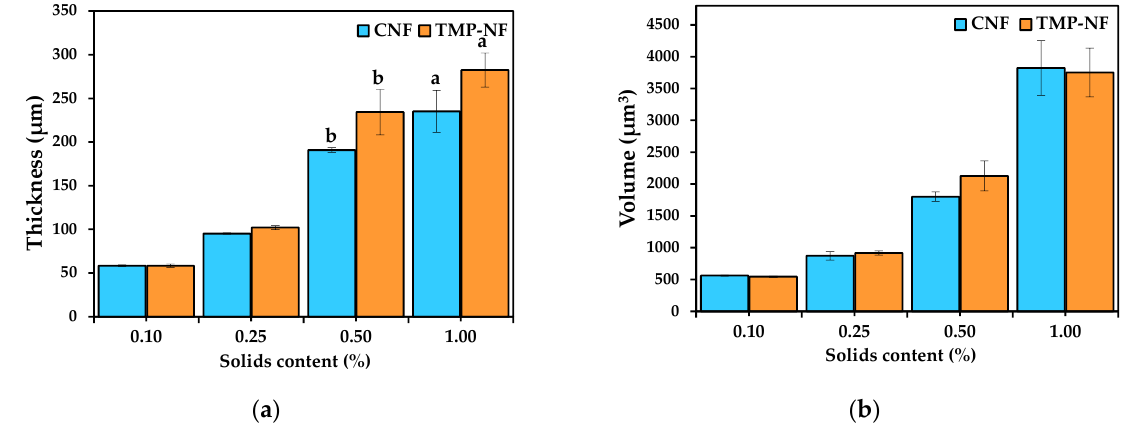
Figure 10. Physical properties for developed films. ( a ) Thickness; ( b ) Volume. Note: Values are presented as means ± SD. N = 6. Values followed by common letters in the super index indicate estimated significant differences between each pair of means media ( p > 0.05).